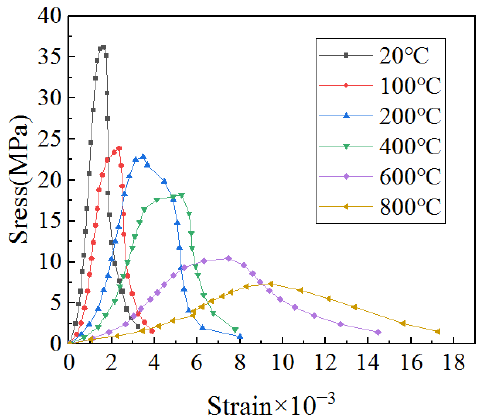
Figure 3. Stress − strain curve of concrete during the uniaxial compressive test after different heated temperatures. Table 2. Peak stress and peak strain of the uniaxial compressive test after different heated temper- atures.